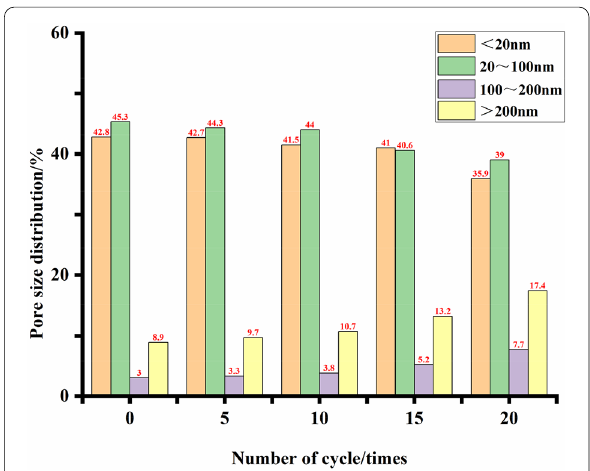
Fig. 14 The pore size distribution of concrete at different single-side salt-freezing–drying–wetting cycles (BFRC2).